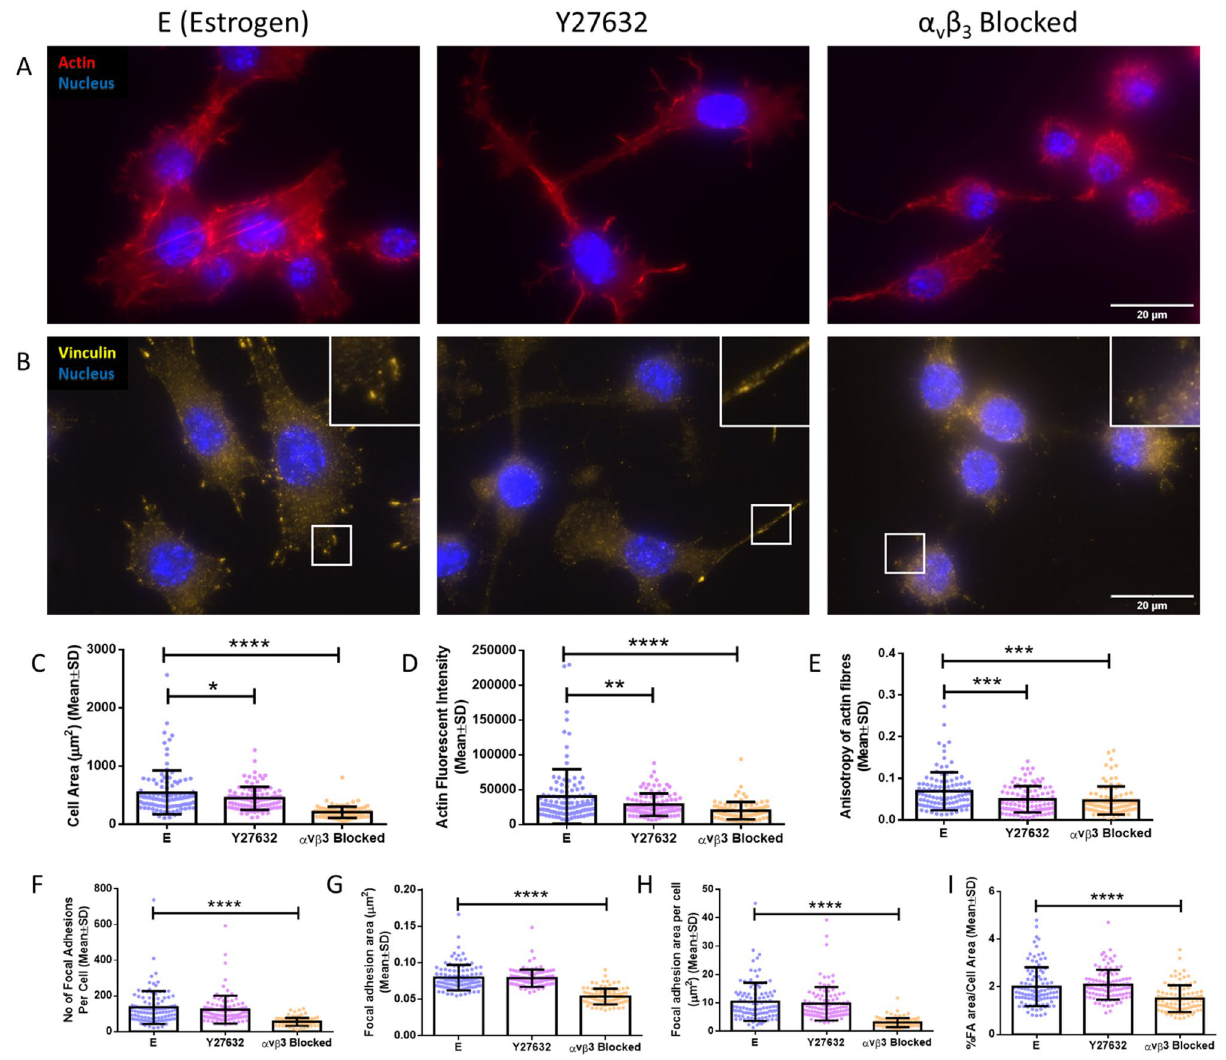
Figure 5. The effect of actin contractility inhibition (E + Y27632) and α v β 3 antagonism (E + α v β 3 antagonism) on the actin cytoskeleton and focal adhesion assembly. Immunocytochemistry images showing (A) actin and nuclei staining and (B) vinculin and nuclei staining (N = 3, n ≥ 95 cells per group). Quantification of the images showing (C) cell area, (D) actin fluorescent intensity, (E) anisotropy of the actin fibres, (F) number of focal adhesions per cell, (G) focal adhesion area, (H) focal adhesion area per cell, and (I) % focal adhesion area/cell area. (Student’s t-test, *p < 0.05, **p < 0.01, ***p < 0.001, ****p <